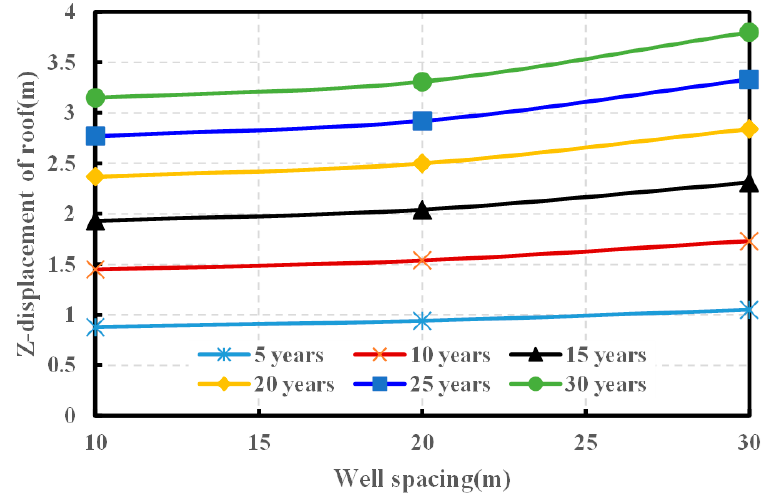
Figure 13. Z ‐ displacement of cavern roof with different well spacings at different operating times. Figure 13. Z-displacement of cavern roof with different well spacings at different operating